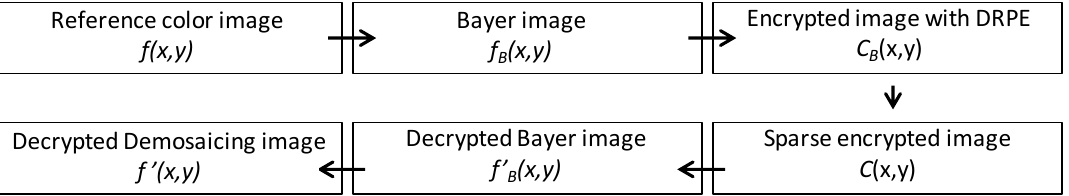
Figure 3. Flow diagram of the proposed color image authentication method.